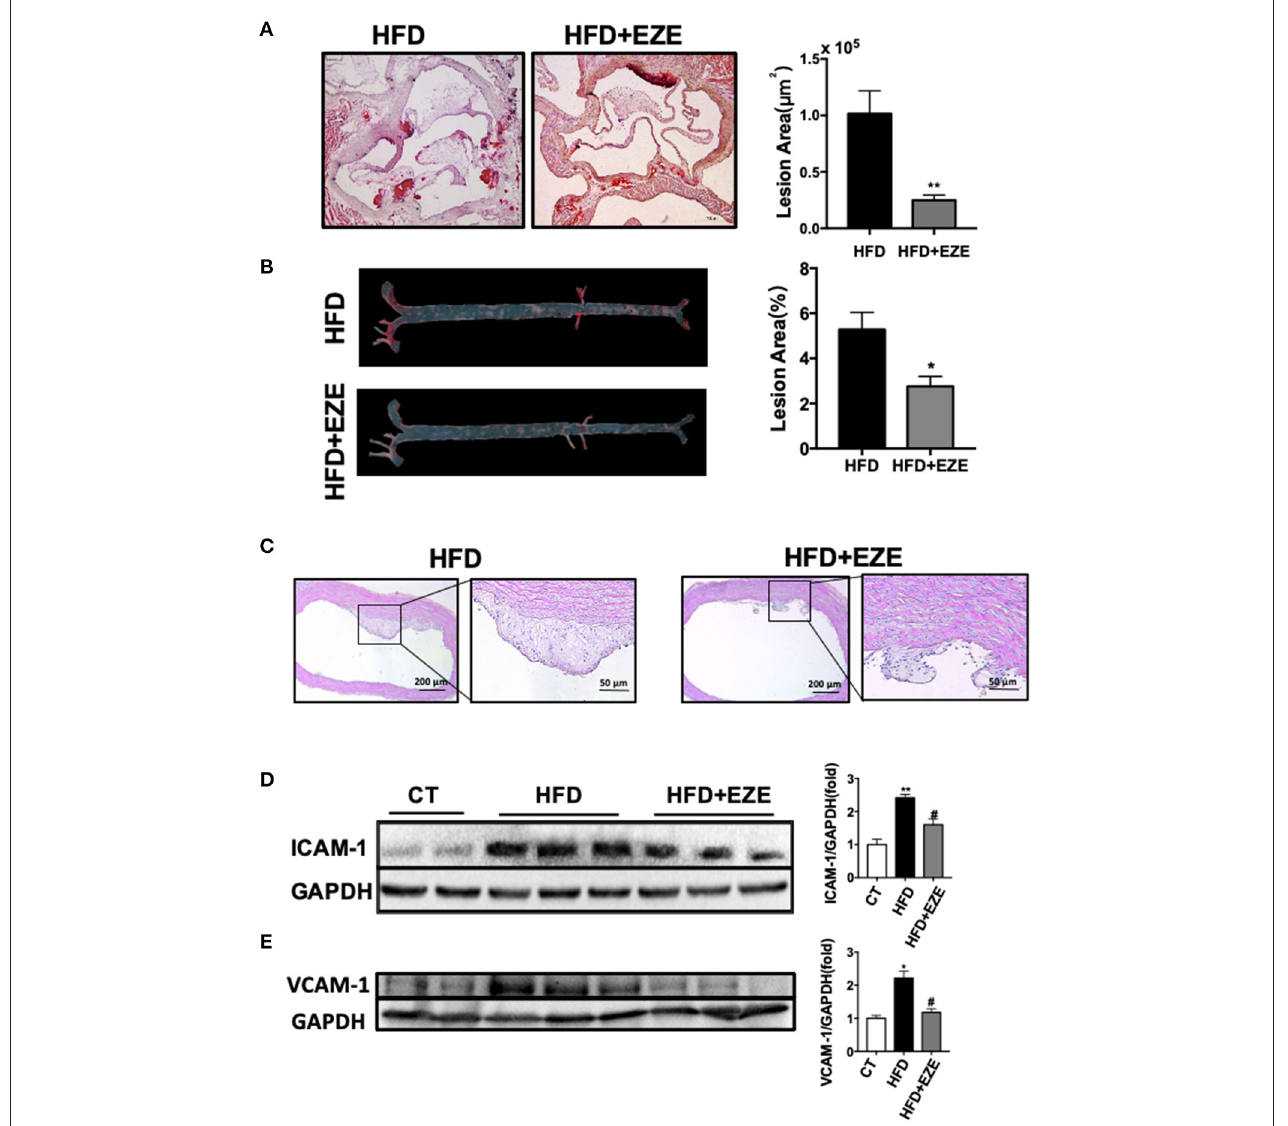
FIGURE 3 | Atherosclerosis is attenuated in LDLR − / − hamsters treated with ezetimibe after 40 days of HFD. Representative pictures of histochemistry sections of the aortic root (A) and en face analysis of the whole length of the aorta (B) by oil red O staining ( n = 10). Scale bars, 500 µ m. Total absolute oil red O positive area in all sections of the aortic root (B) and relative oil red O-positive area of the aorta en face ( n = 10). Data are shown as mean ± SEM. * p < 0.05, ** p < 0.01 compared with the HFD group, where the one-way ANOVA with Tukey’s multiple comparisons test was performed. (C) Representative images of H&E staining of sections of the aortic arch. Scale bar = 200 or 50 µ m, respectively. The expression of ICAM-1 (D) and VCAM-1 (E) in cultured HUVECs was analyzed by western blotting, the right panel was the quantitative bar chart analysis of the left panel. The serum from normal CD-fed WT hamsters was used as the control, the expression of ICAM-1 and VCAM-1 incubated with serum from HFD diet-fed hamsters was upregulated and downregulated with the serum from HFD-fed hamsters with ezetimibe administration. Data are shown as mean ± SEM. Two-tailed unpaired t -test, # HFD + EZE vs. HFD, # p < 0.05, and the one-way ANOVA with Tukey’s multiple comparisons test was